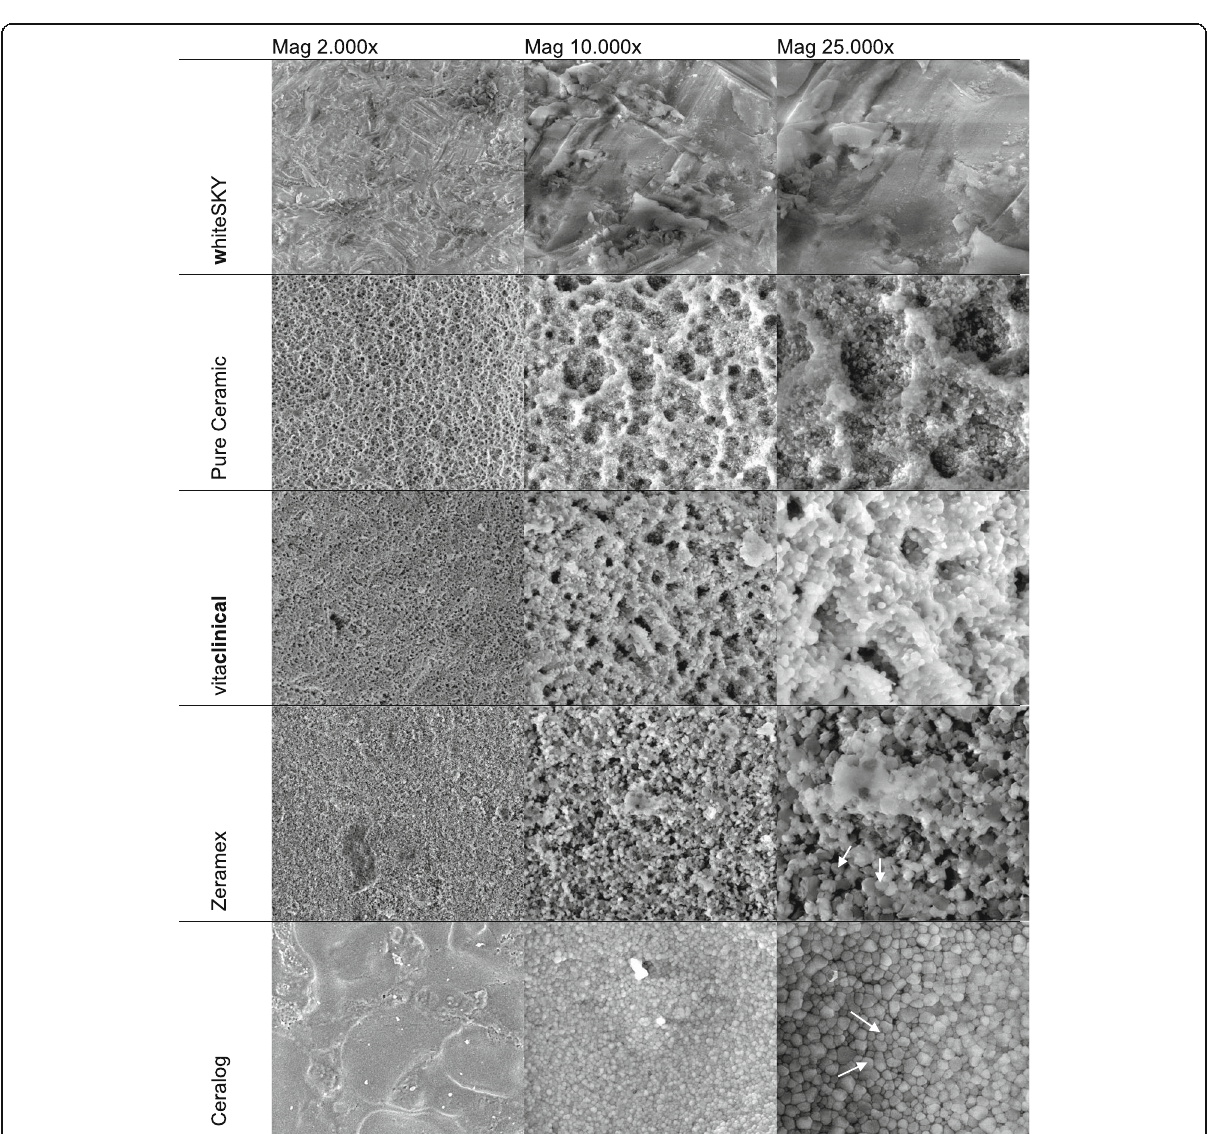
Fig. 2 SEM. White arrow ( → ) exemplary mark the droplet like shape of surface as described in the